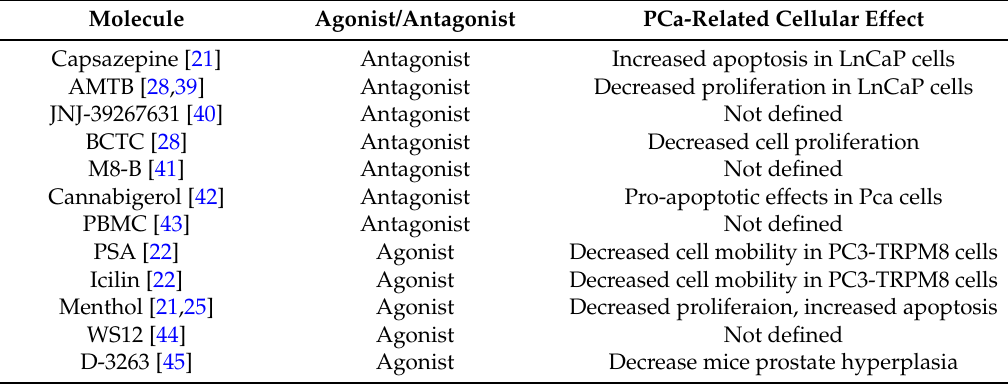
Table 1. TRPM8 modulators can be used in research therapies against PCa.